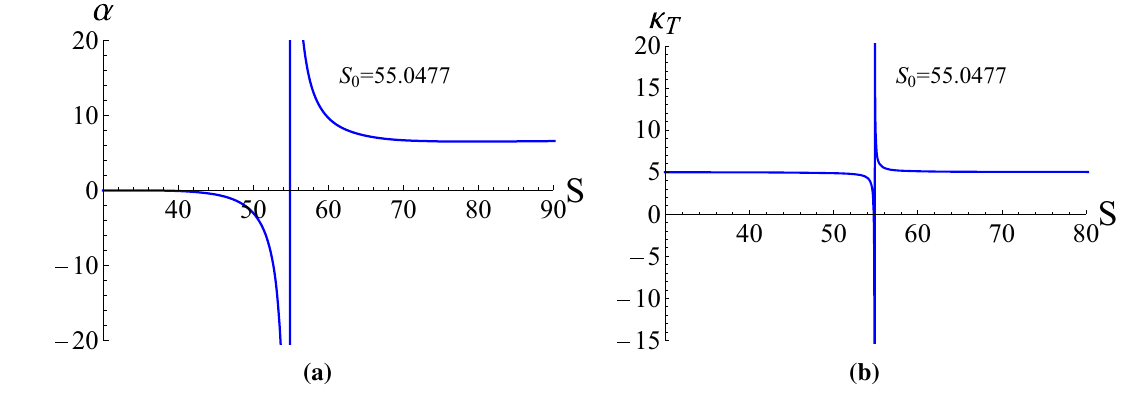
Fig. 11 Entropy ( S ) with different α and k T (for the charged hairy black holes with q = − 0 . 2 and φ eff = 0 .